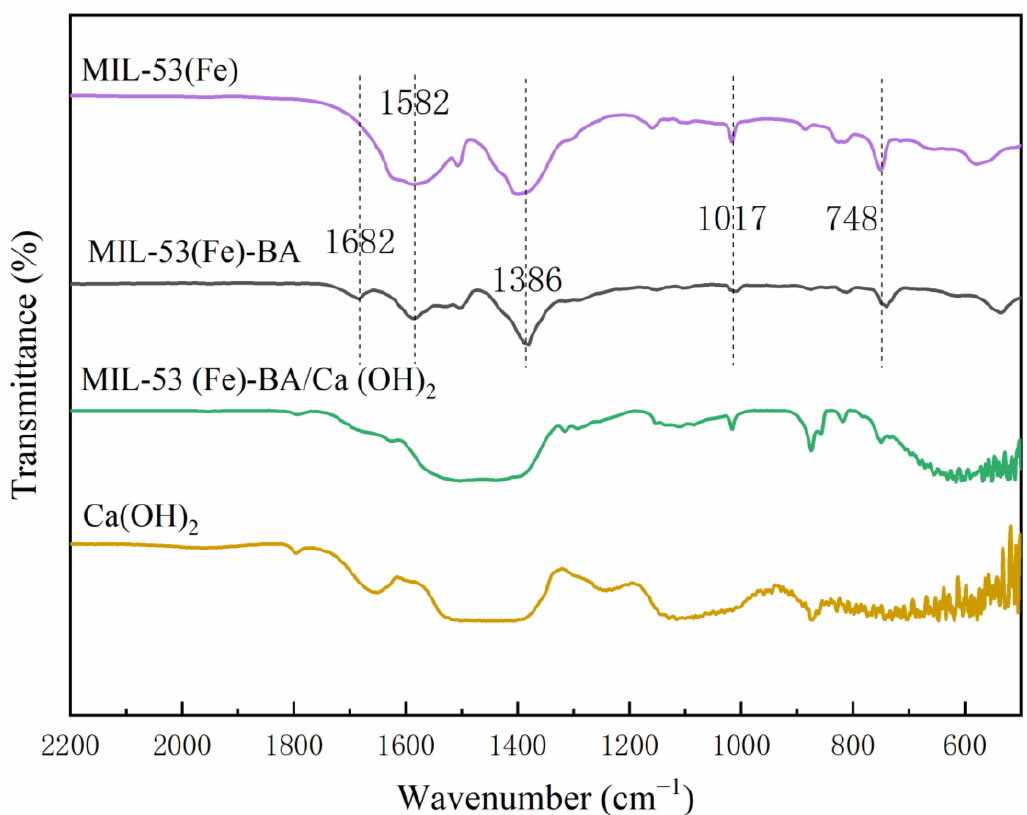
Figure 6. The FT-IR spectra of the synthesized MIL-53(Fe)-based additives and new desulfurizers.